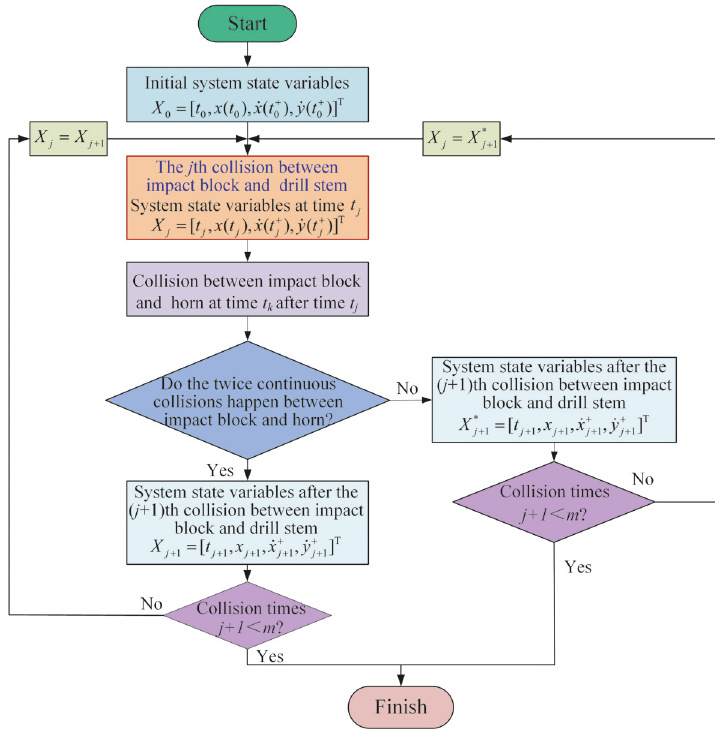
Figure 6: The flowchart of the impact